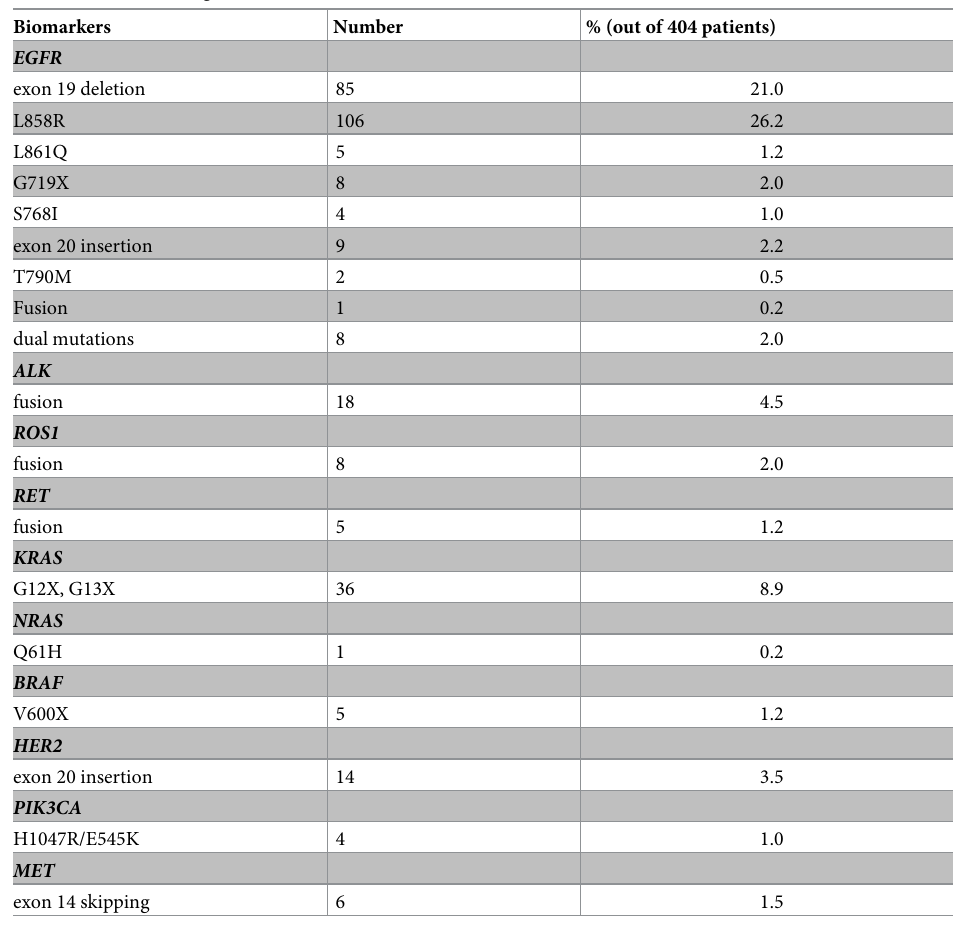
Table 2. Prevalence of genetic